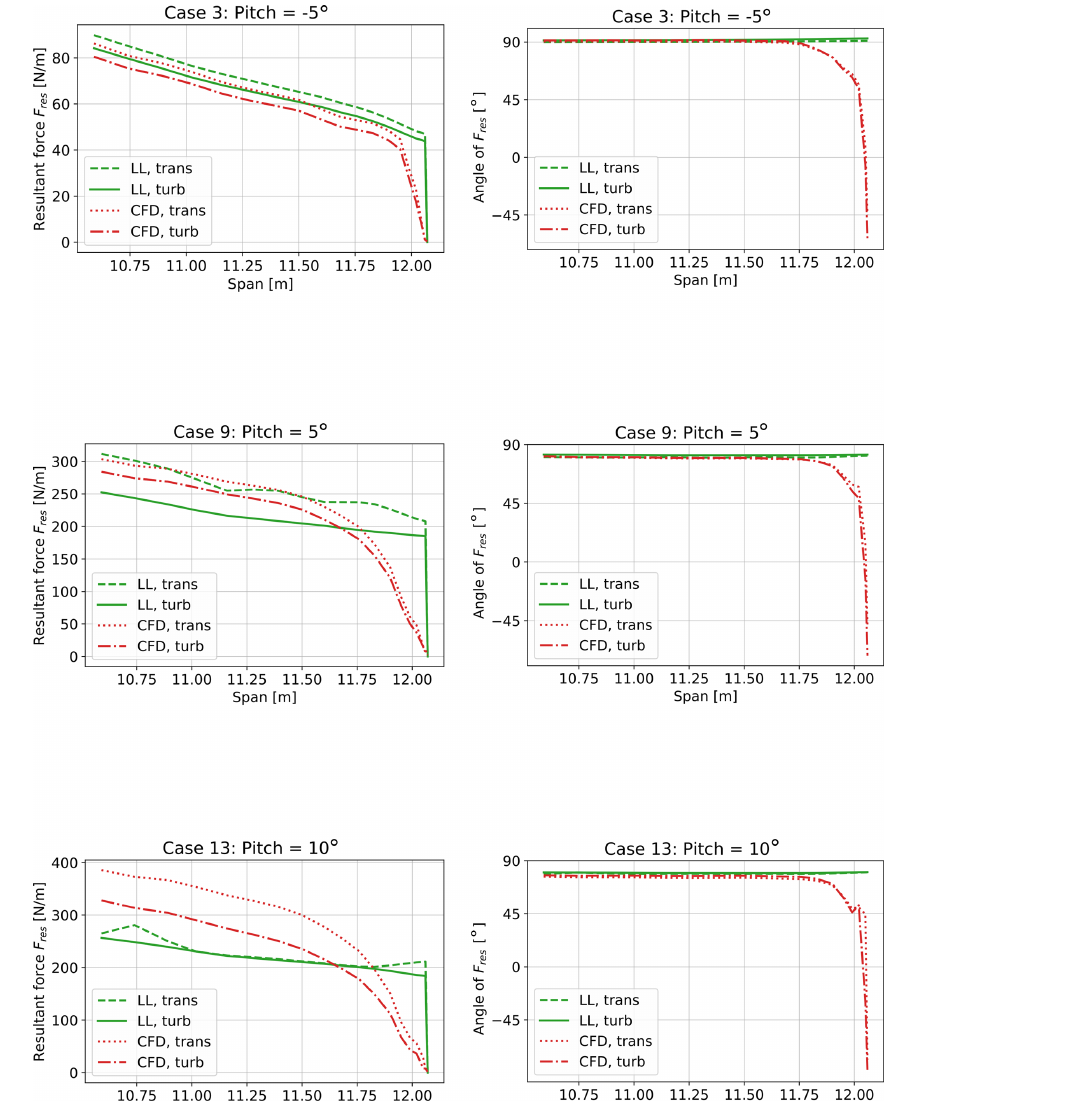
Figure 15. Comparison of resultant force magnitude (left panels) and angle (right panels) between LL and CFD for cases 3, 9, and 13 from Table 2. Clearly, the spikes in chordwise force towards the tip in the CFD results shown in Fig. 12 are due to a rotation of the